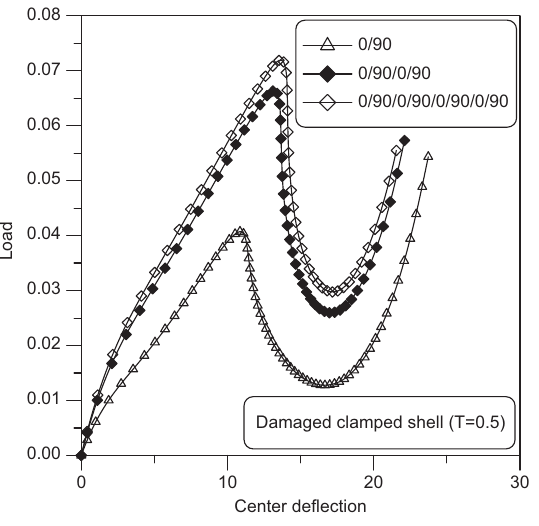
Figure 15 Load-displacement curves of clamped cylindrical shell.